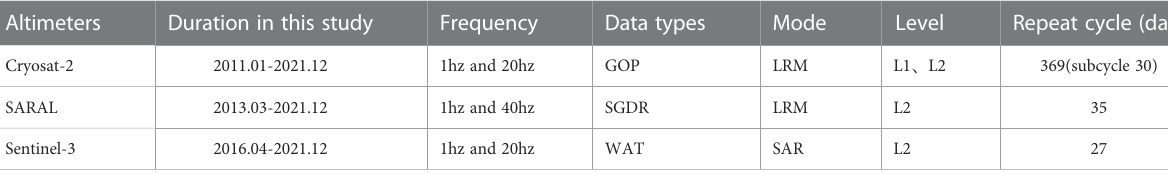
TABLE 1 Summary of main parameters of three radar